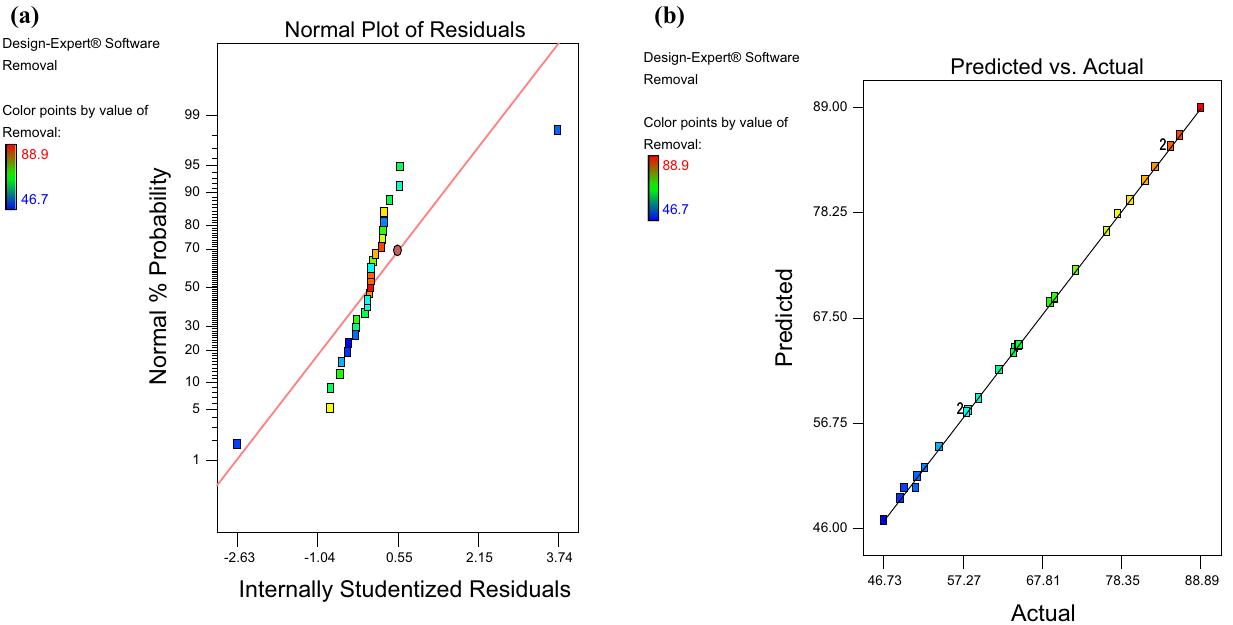
Fig. 10 a Plot of normal % probability versus residual error, b comparison between the actual values and the predicted values of RSM model for adsorption of